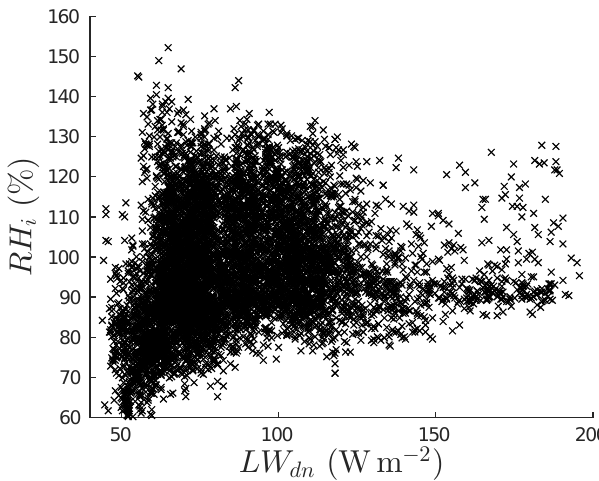
Figure 3. Scatter plot of observed RH i between 60 and 160% (from HMPmod) versus 10m wind speed. All available half-hourly data in 2015 are